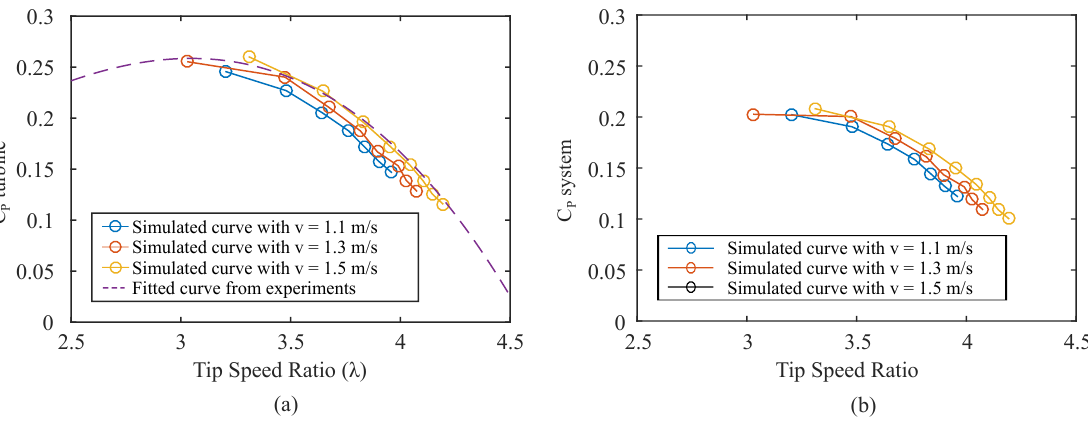
Figure 7. Simulated and experimentally measured C P -curve: ( a ) C P losses); ( b ) C P for the total system (including all mechanical and electrical losses).